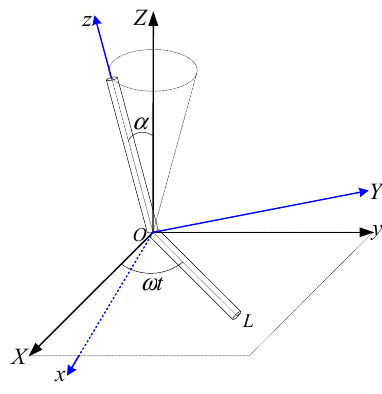
Figure 3. Conical motion around the Z-axis.